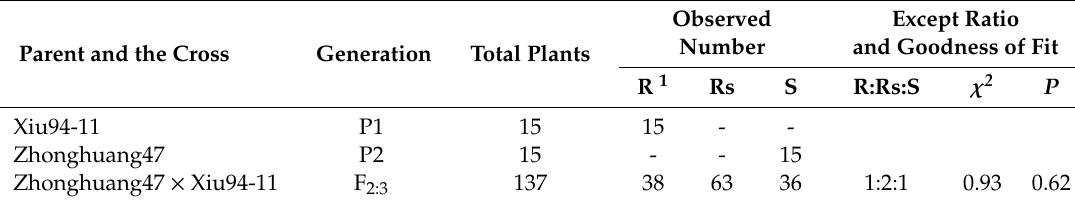
Table 2. Genetic segregation in response to Phytophthora sojae isolates PsMC1 and PsJS2 in 137 F 2:3 families derived from a cross between soybean cultivars Zhonghuang47 and Xiu94-11.